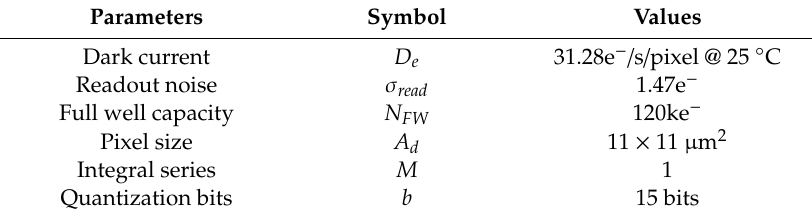
Table 3. Parameters of the image detector.